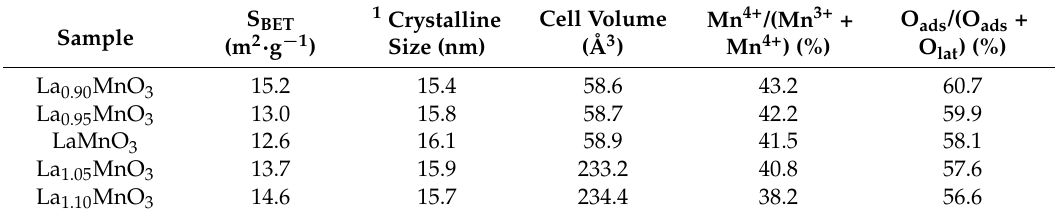
Table 1. Physicochemical properties of La x MnO 3 catalysts.